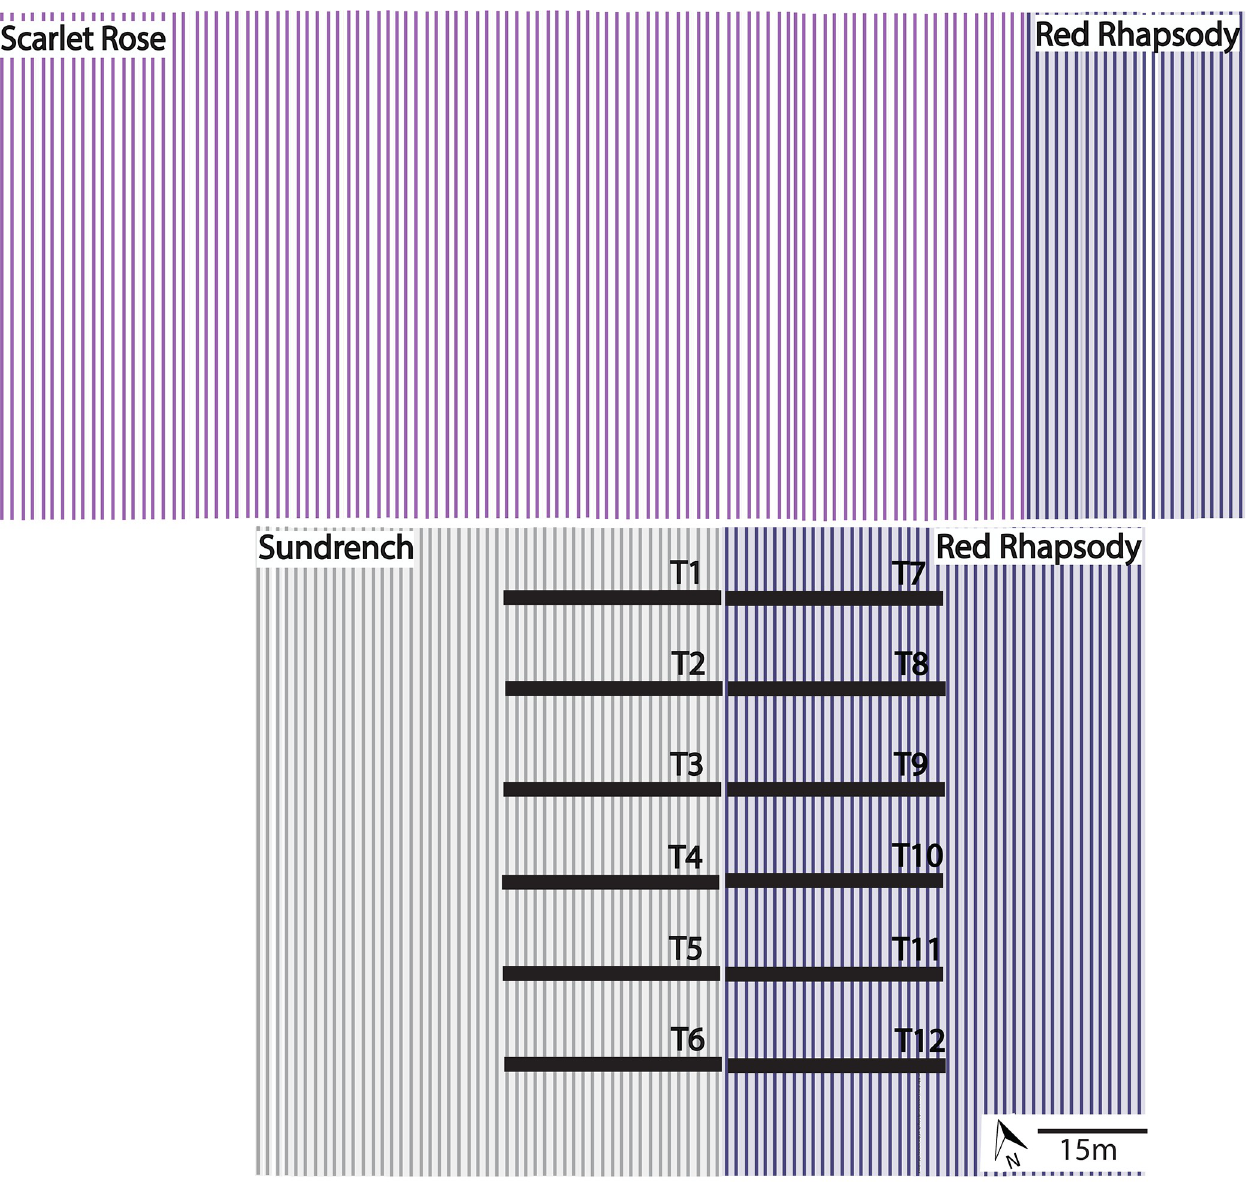
Fig 1. Strawberry farm design, consisting of 49 rows of cultivar Sundrench next to 44 rows of cultivar Red Rhapsody. ‘T1’ to ‘T6’ show the six sampling transects for cultivar Sundrench, and ‘T7’ to ‘T12’ show the six sampling transects for cultivar Red Rhapsody. North of the experimental block are 103 rows of cultivar Scarlet Rose next to another 19 rows of Red Rhapsody. Flower visitors were observed and fruit collected from each transect at rows 1, 3, 10 and 20 from the other cultivar.